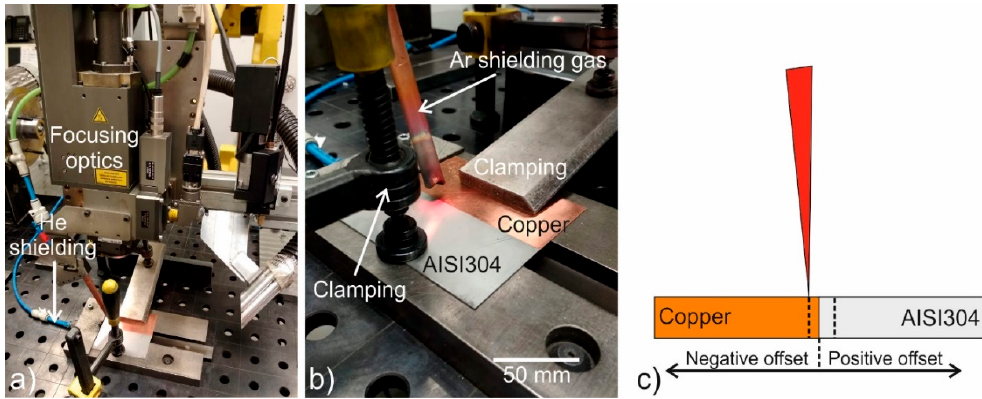
Figure 1. ( a ) Disk laser welding workplace; ( b ) setup to welded materials; ( c ) schematic overview of